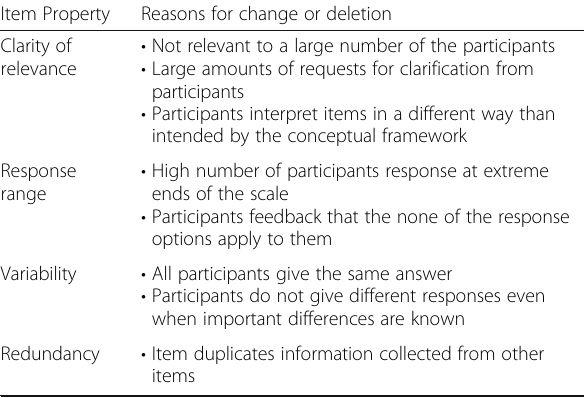
Table 2 Reasons for changing items during pre-testing (Adapted from [17]) Item Property